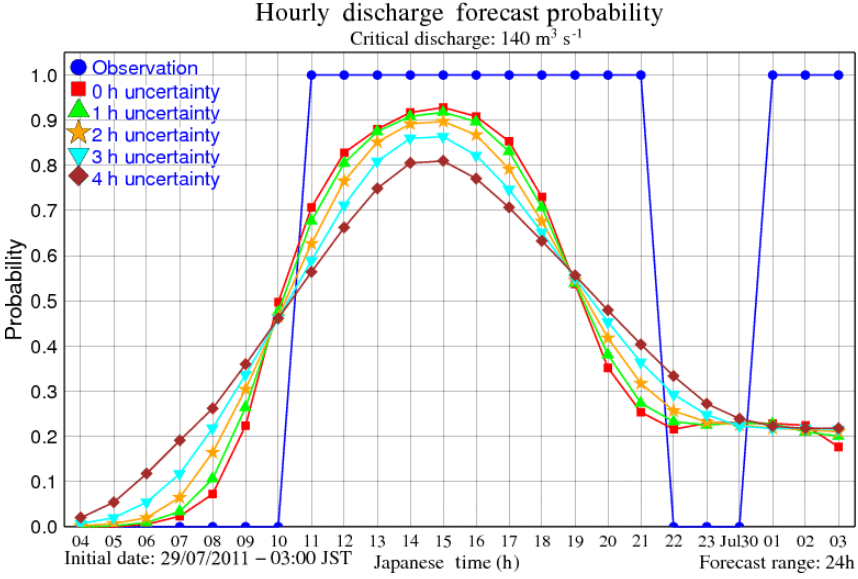
Figure 7. Probability that the simulated inflow is beyond 140m 3 s − 1 considering temporal